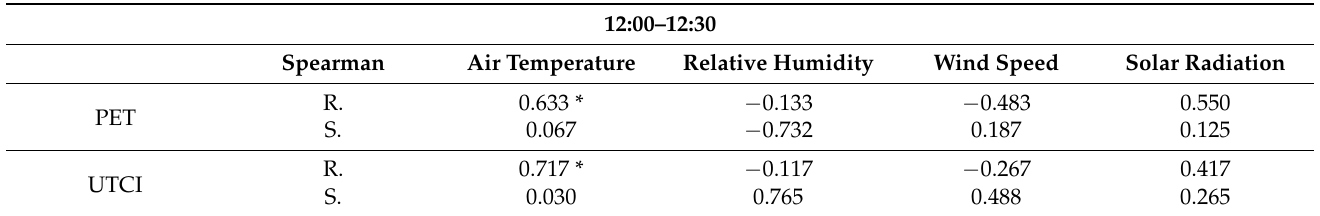
Table 7. The Spearman correlation coefficients of the measured microclimatic parameters and PET and UTCI of 12:00 to 12:30.